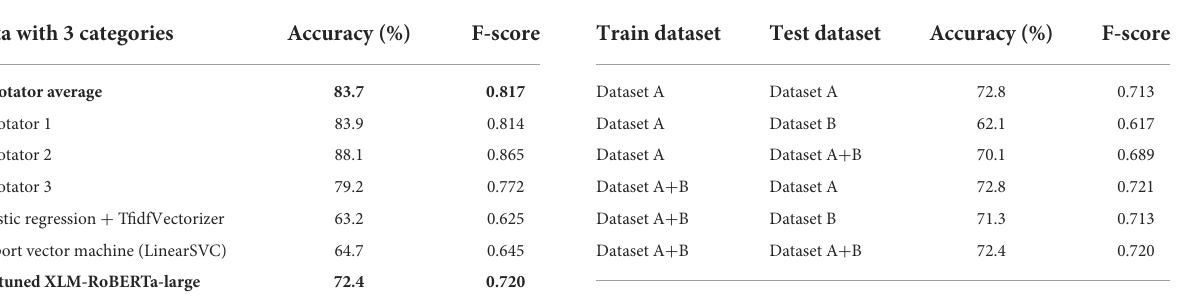
TABLE 4 Accuracy and F-scores for annotators and ML models over full dataset (dataset A + B).